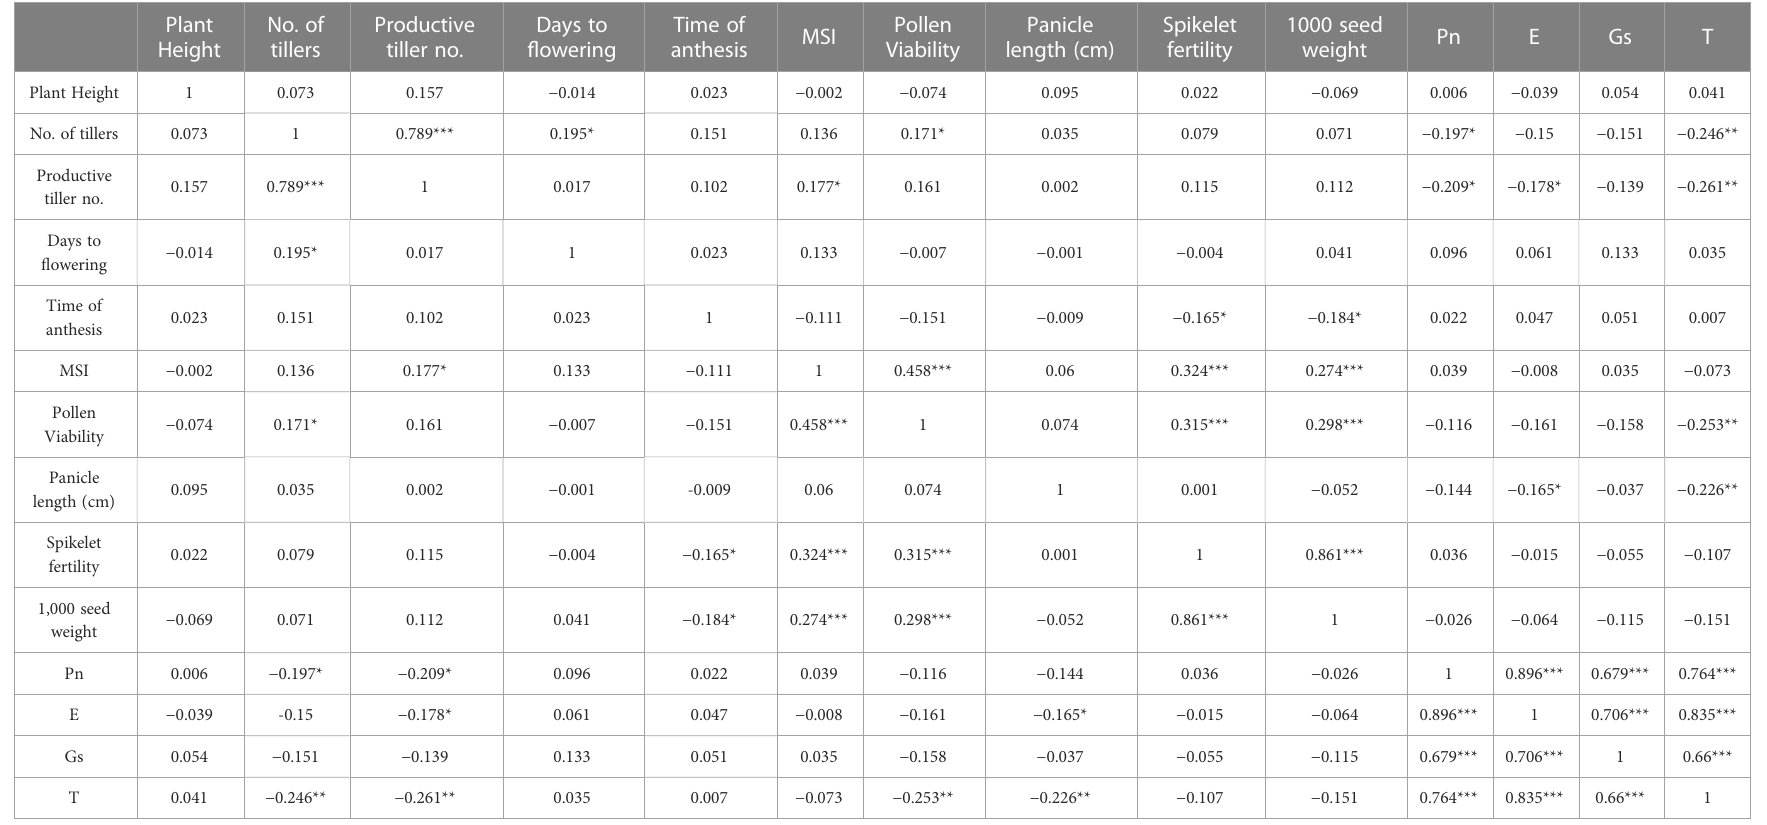
TABLE 3 Correlation matrix of F 2 population under high temperature